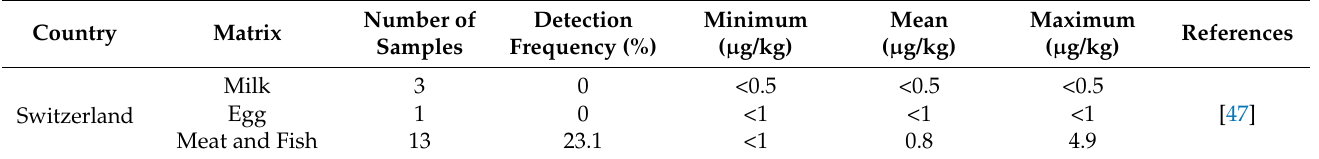
Table 8. Occurrence of glyphosate in animal products.